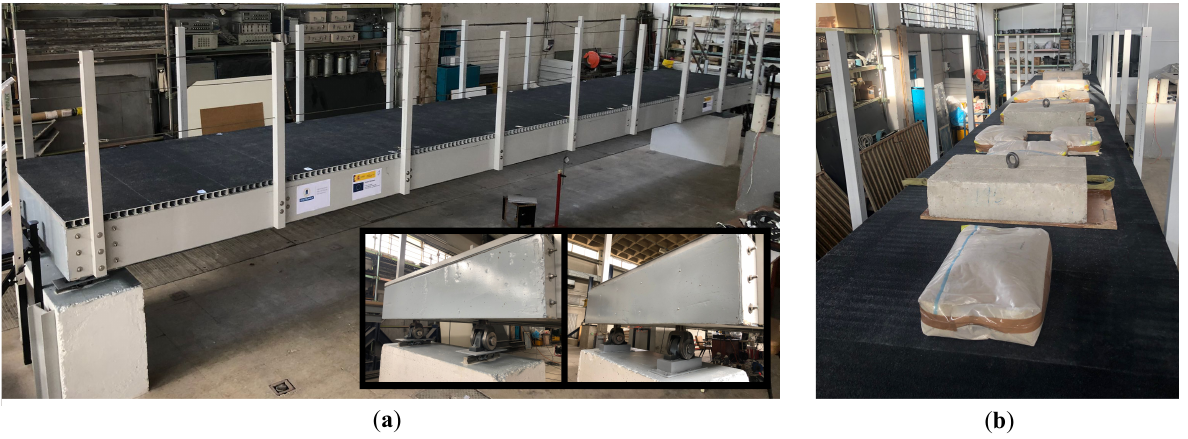
Figure 3. FRP footbridge: ( a ) Simply supported structure. ( b ) Static